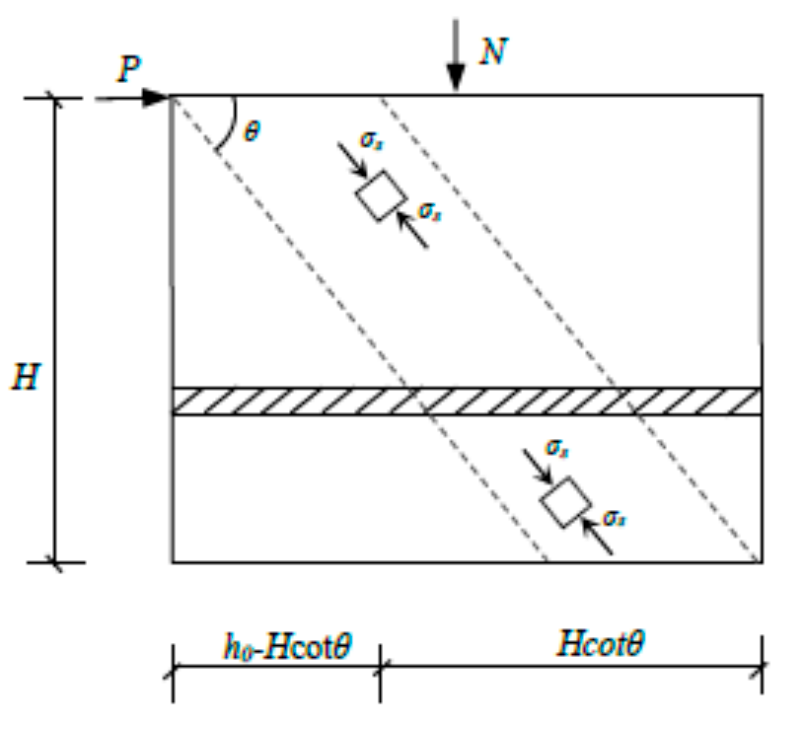
Figure 12. Diagram of diagonal compression strut .